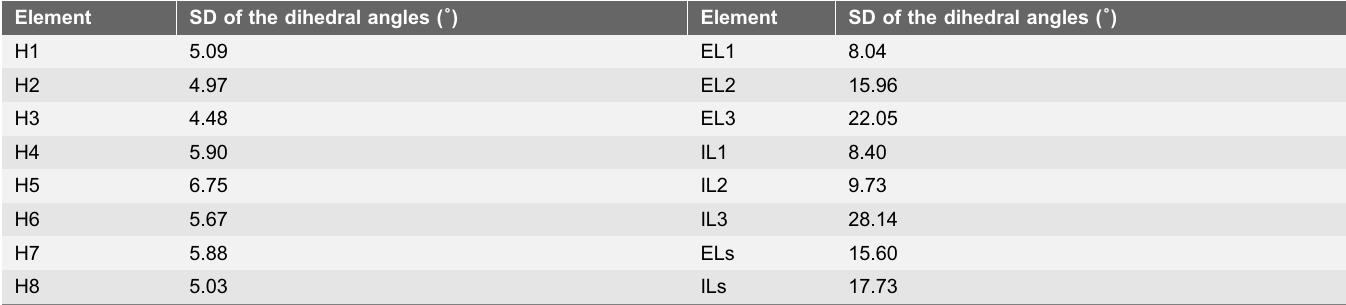
Table 1. Standard deviation (SD) of the mean dihedral angles computed from sequences of four consecutives C a atoms along the m OR backbone from the 0.5 m s all-atom MD simulation. Element SD of the dihedral angles ( ˚ ) Element SD of the dihedral angles ( ˚ )